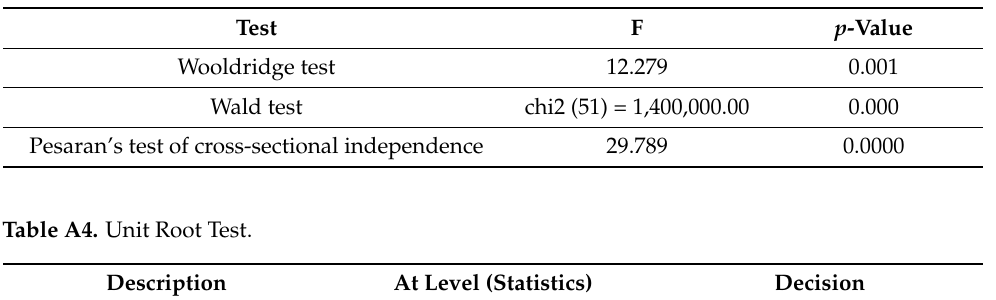
Table A3. Heteroscedasticity and Autocorrelation Test